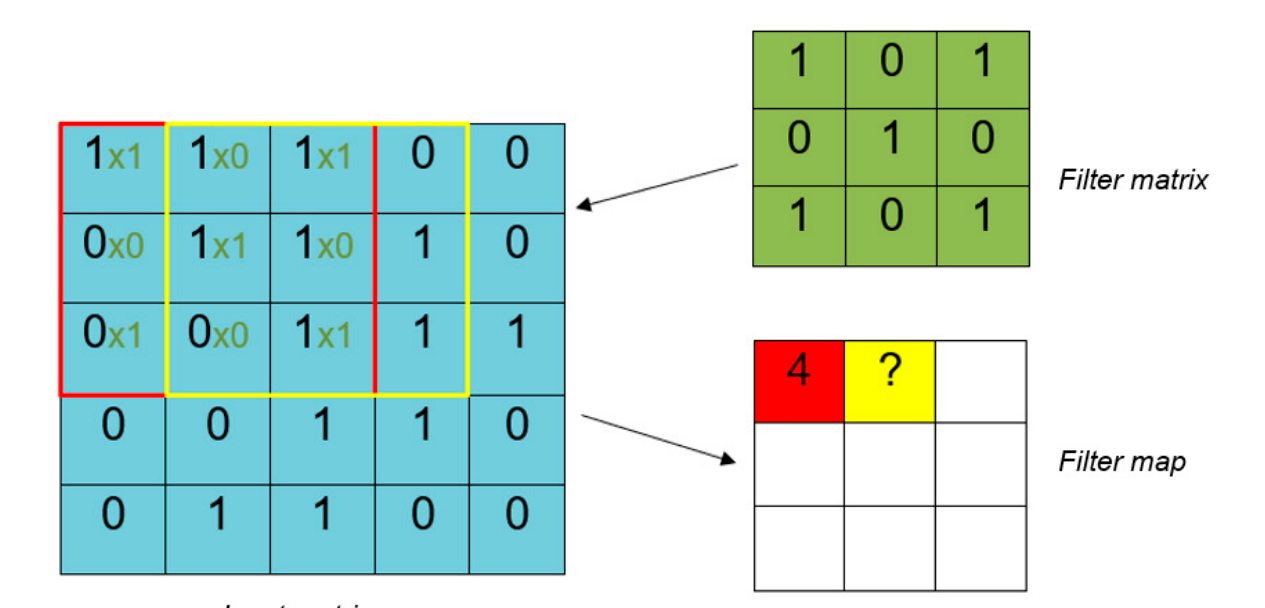
Figure 5. Convolution operation.